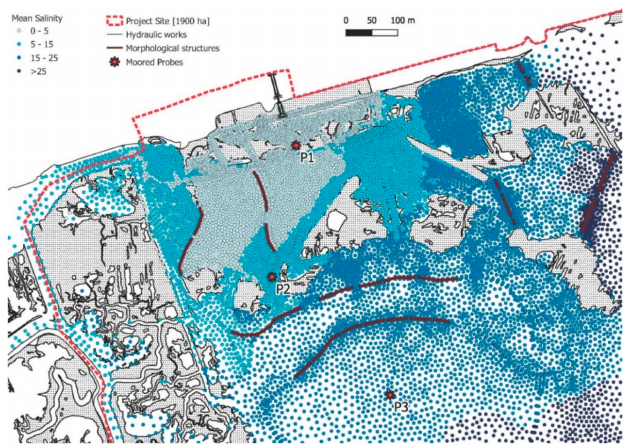
Figure 14. Maps of salinity distribution, evaluated as the mean value computed by the model within the vertical layers 11–14 in each node of the domain, for the period 23 February–10 March 2021, with a discharge of 1000 ls − 1